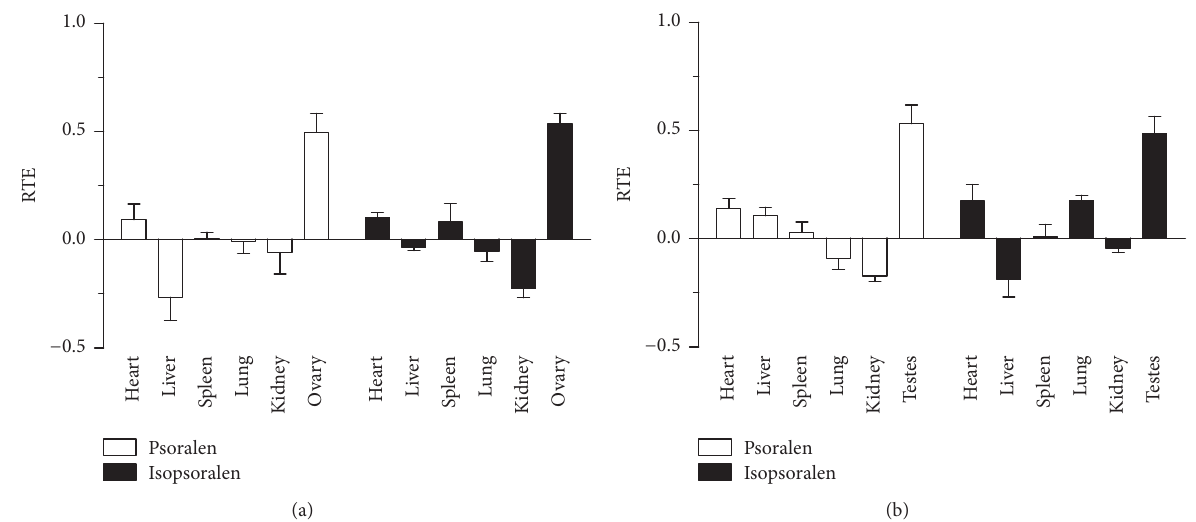
Figure 6: The RTE profiles of psoralen and isopsoralen in male and female rat tissues. (a) Psoralen and isopsoralen in female rat; (b) psoralen and isopsoralen in male